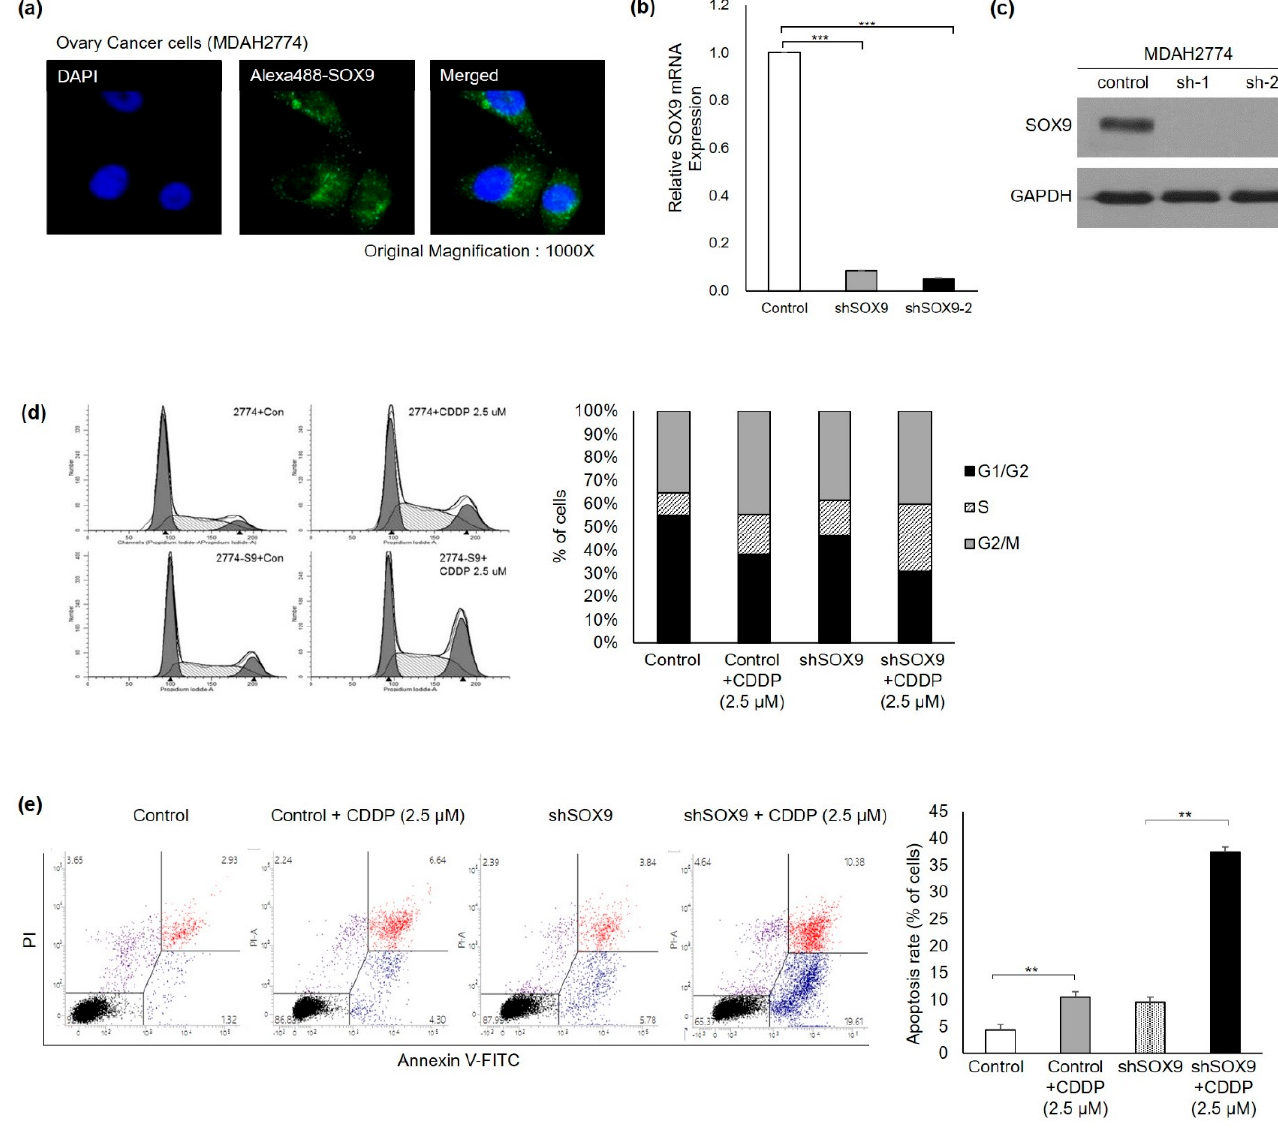
Figure 2. SOX9 silencing induces cancer cell death in vitro and in vivo. Knockdown of SOX9 in MDAH-2774 ovarian cancer cells increase anticancer drug responsiveness and inhibits tumorigen- esis. ( a ) High expression of cytoplasmic SOX9 in MDAH-2774 was confirmed by immunocytochem- istry. Alexa-488 (green) was used as a secondary antibody to visualize SOX9 protein expression.